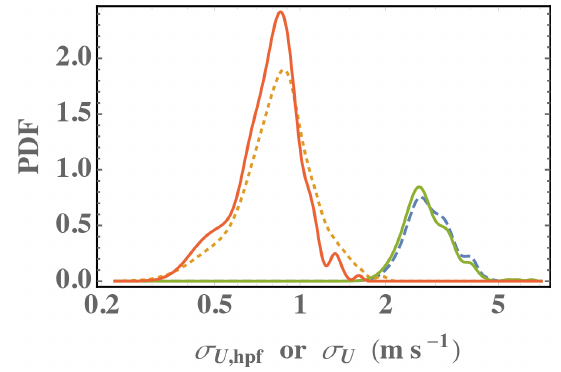
Figure 4. Probability density functions of standard deviation of wind speed over all ramp periods. Dashed-blue line is unfiltered σ u over all ramps; dashed-orange line is high-pass filtered turbulence ( σ u, hpf ); solid green line is σ u excluding events exceeding V cut or starting above V rated ; solid red line is σ u, hpf also excluding such events.